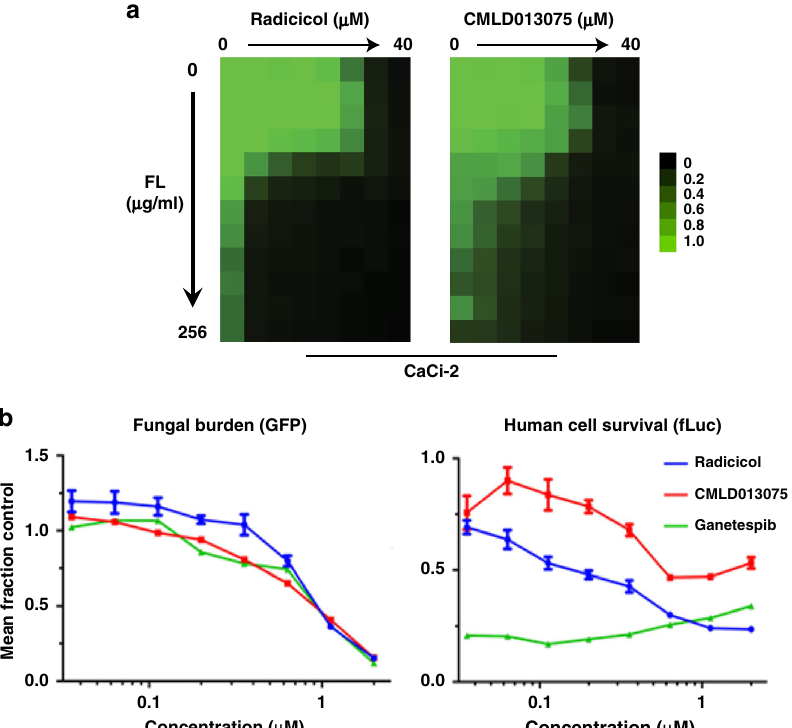
Fig. 8 CMLD013075 reverses antifungal resistance in co-culture. a Checkerboard analysis of antifungal activity for combination of FL with Hsp90 inhibitors. FL-resistant strain CaCi-2 was exposed to the indicated twofold serial dilutions of each compound for 48 hours. Relative growth inhibition is displayed in heat-map format. Each colored box represents the mean of duplicate determinations. Color scale for relative growth is provided to the right of panel, green: no inhibition to black: complete inhibition. The experiment was repeated as an independent biological replicate to con fi rm results. b Co-culture of fl uconazole (FL)-resistant, GFP-expressing C. albicans strain with human 293T cells line stably expressing a luciferase reporter. The concentration- dependent inhibition of fungal (left) and human (right) cell growth and survival by Hsp90 inhibitors in the presence of FL was measured in 384-well format after 48-h treatment. Relative fungal burden was evaluated by plate reader using a fl uorescence endpoint while human cell survival was evaluated by measuring luminescence. Values for each endpoint were normalized to wells receiving no Hsp90 inhibitor. Each point represents the mean of measurements from triplicate wells. Error bars, SD. The experiment was repeated once as an independent biological replicate to con fi rm